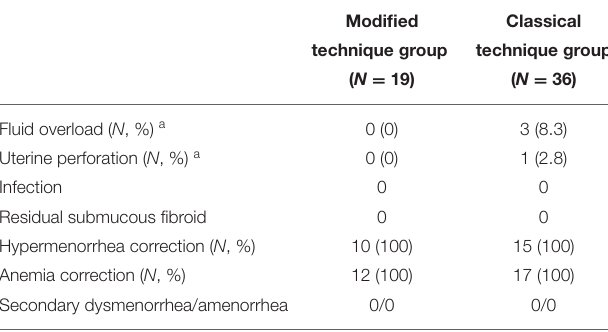
TABLE 3 | Postoperative data of patients in the two